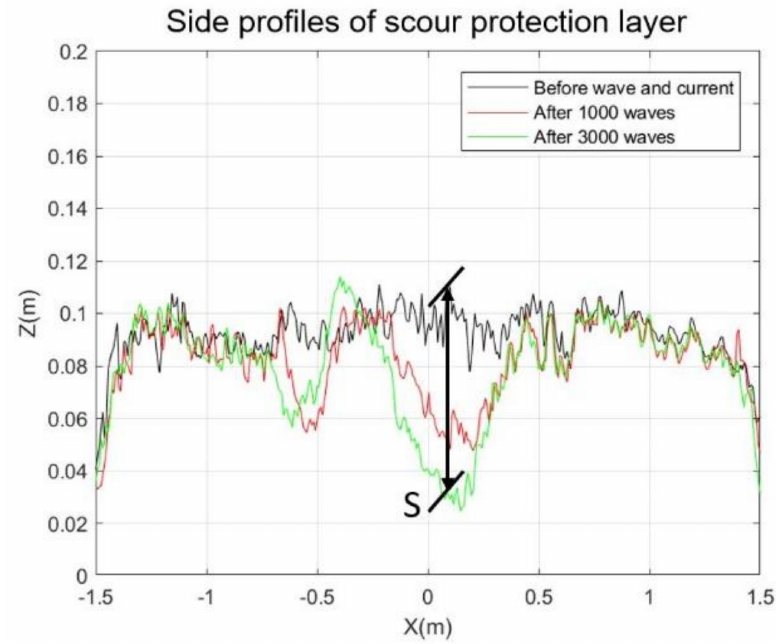
Figure 14. Definition of the maximum damage depth (S) of the scour protection